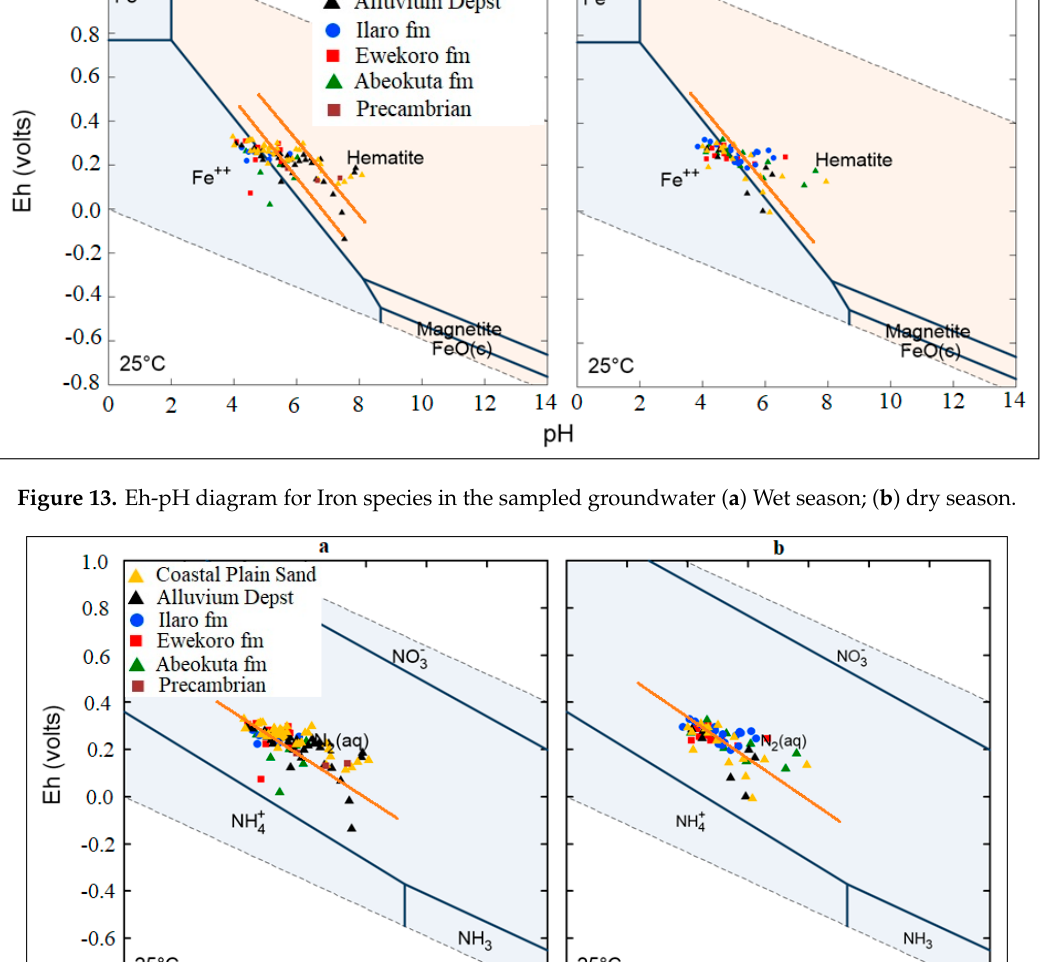
Figure 12. General Eh-Ph diagram for both wet and dry season groundwater samples. The upper and lower stability limits of water are given where PO 2 and PH 2 = 1 bar. The dry season shows more extensive variation in the thermodynamic phase, while both are generally plotted within the transitional phase .